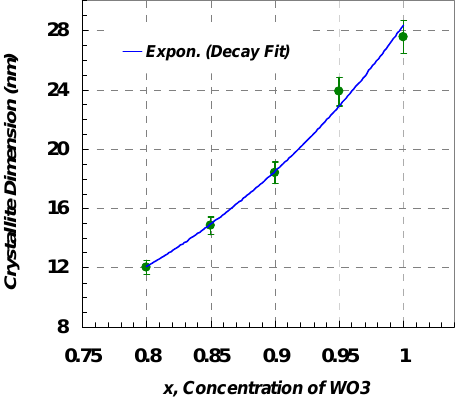
( 1-x )Y O determined by the Scherrer Equation. 3 2 3